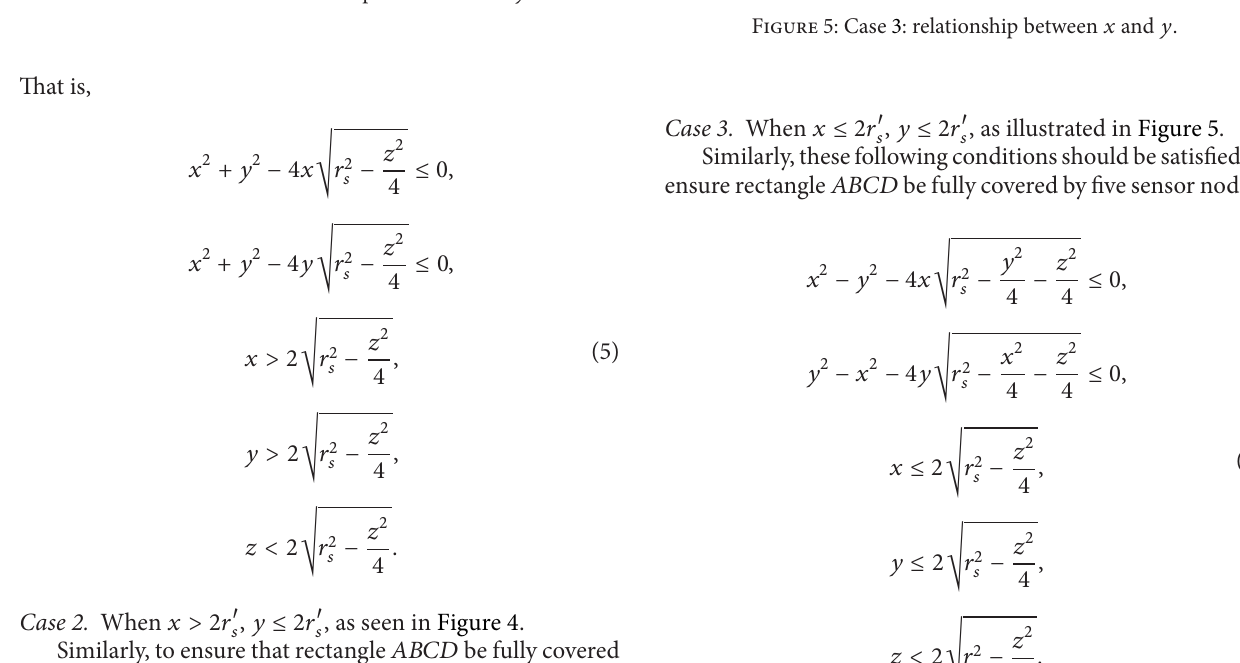
Figure 4: Case 2: relationship between 𝑥 and 𝑦 .